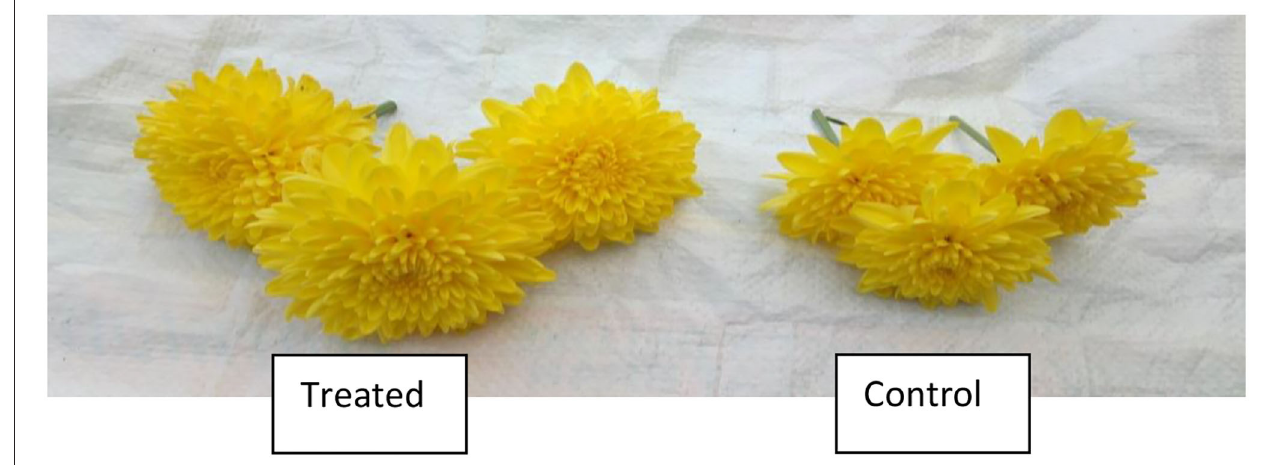
FIGURE 12 | Effect of humic acid on growth of Chrysanthemum flowers.